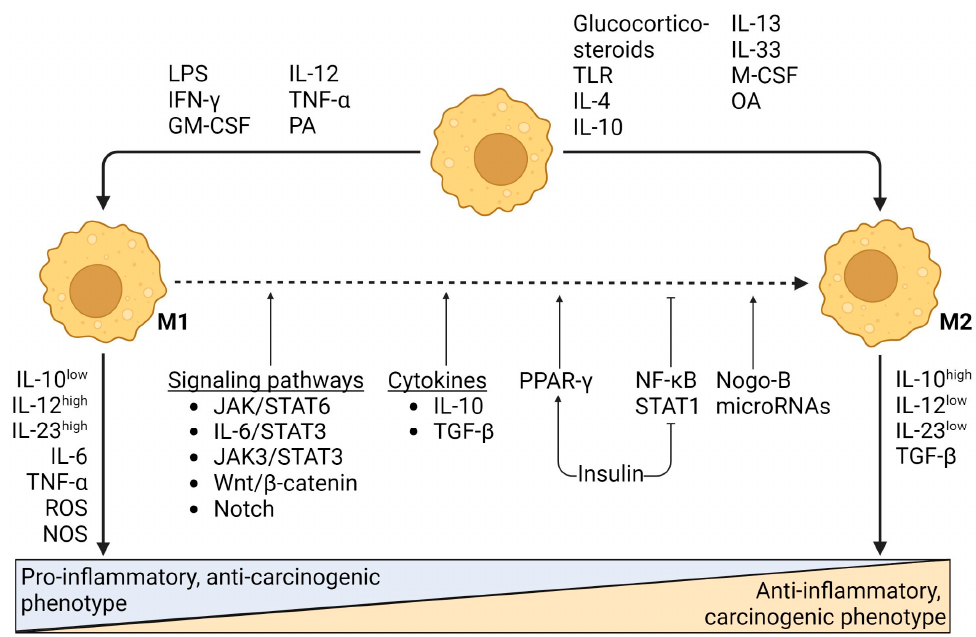
Figure 1. Schematic summary of M1- and M2-type macrophages and the mechanisms underlying polarization and phenotype switching in the context of NAFLD.